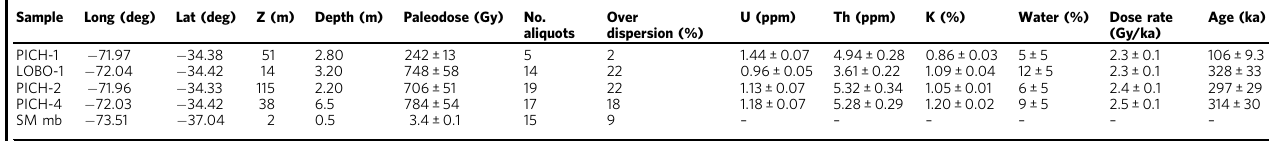
Table 1 Post-IR IRSL samples.